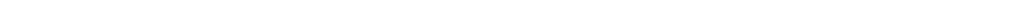
(see fi gure on previous page) Fig. 3 Lnc-LALC promoted CRC cells migration and invasion in vitro. A The knockdown ef fi ciency of lncLALC by sh-lncLALC was assessed by qRT-PCR in LoVo cells. B The overexpression ef fi ciency of lncLALC by Lv-lncLALC was assessed by qRT-PCR in SW480 cells. C Wound-healing assay showed that knockdown of Lnc-LALC inhibited the migratory ability of LoVo cells and knockdown of LZTS1 could recover this inhibiting effect; overexpression of Lnc-LALC promoted the migratory ability of SW480 cells and overexpression of LZTS1 could recover this promoting effect. * P < 0.05 (original magni fi cation × 40). D Transwell assay showed that knockdown of Lnc-LALC inhibited the invasive ability of LoVo cells and knockdown of LZTS1 could recover this inhibiting effect; overexpression of Lnc-LALC promoted the invasive ability of SW480 cells and overexpression of LZTS1 could recover this promoting effect(original magni fi cation × 100). * P < 0.05. The data represent the mean ± SD from three independent experiments.